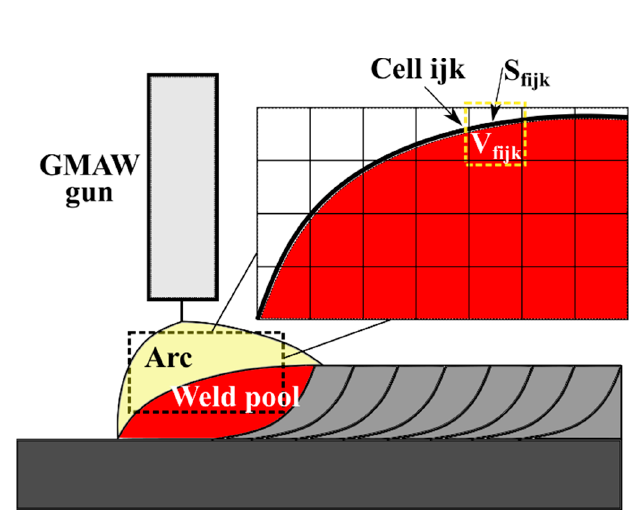
Figure 1. The adaptive heat source.